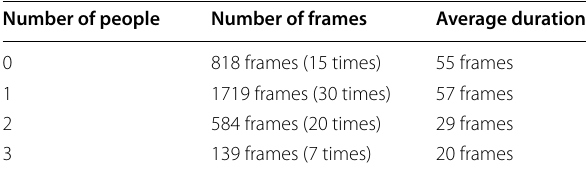
Table 3 The details of the number of people, except the target, in off-line experiments